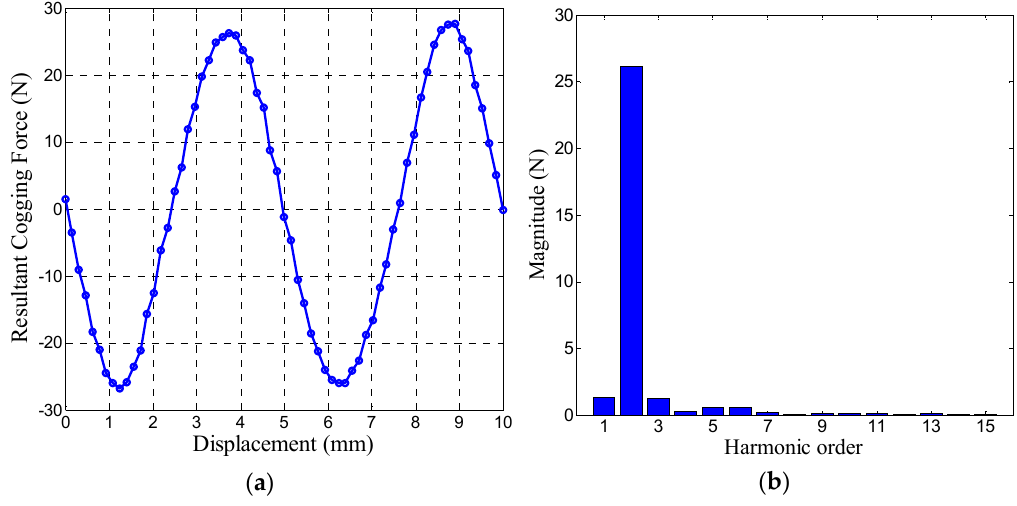
Figure 8. Resultant cogging force after performing the armature core optimization and the auxiliary core offset. ( a ) Waveform; ( b ) Harmonic spectrum.